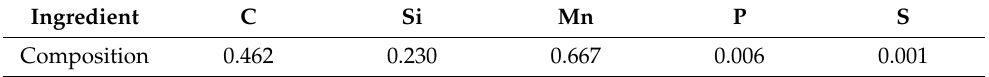
Table 2. Test results for the chemical composition of gearbox boom sent for inspection (mass, %).